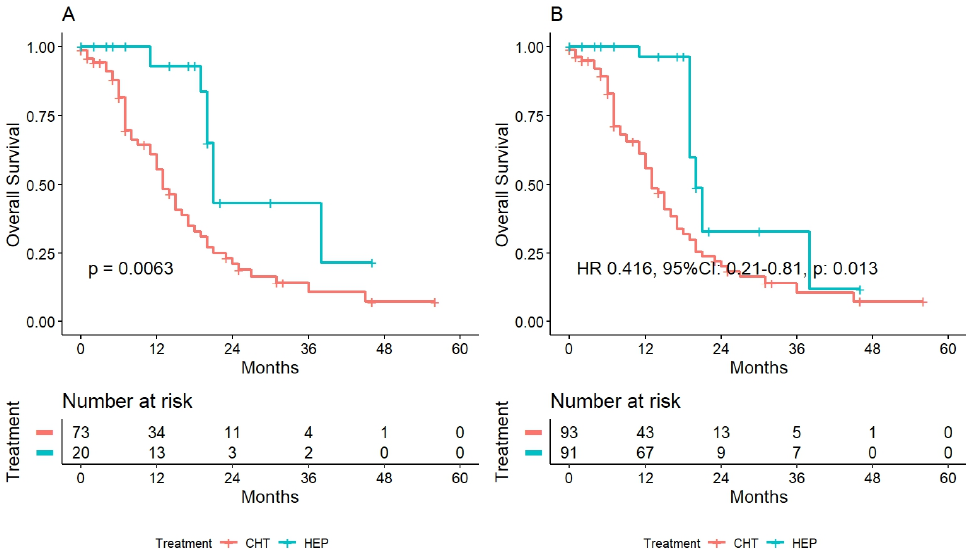
Figure 3. Overall survival among hepatectomy following II-line perioperative chemotherapy (HEP) and prosecution of chemotherapy alone in case of disease progression: ( A ) before the inverse probability weighting and ( B ) after it.